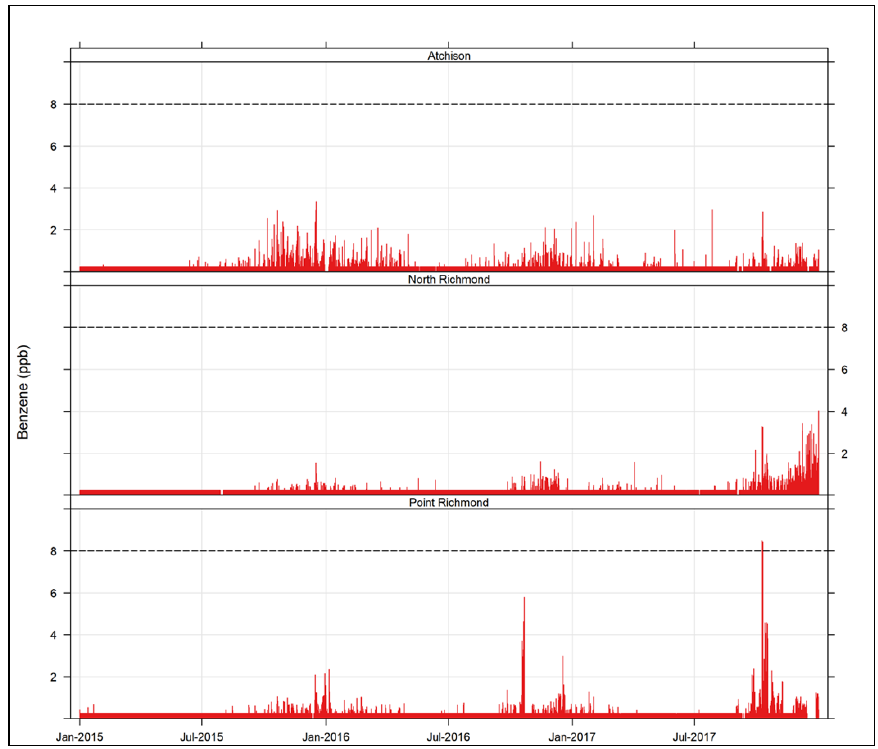
Figure 2. Benzene 1-h average concentration (ppb) at the three community monitoring stations, including Point Richmond, North Richmond and Atchison Village. Dashed line indicates the California OEHHA acute (1-h) REL for benzene. Non-detect data (below a detection of 0.5 ppb) were replaced with one-half the detection limit (0.25 ppb).